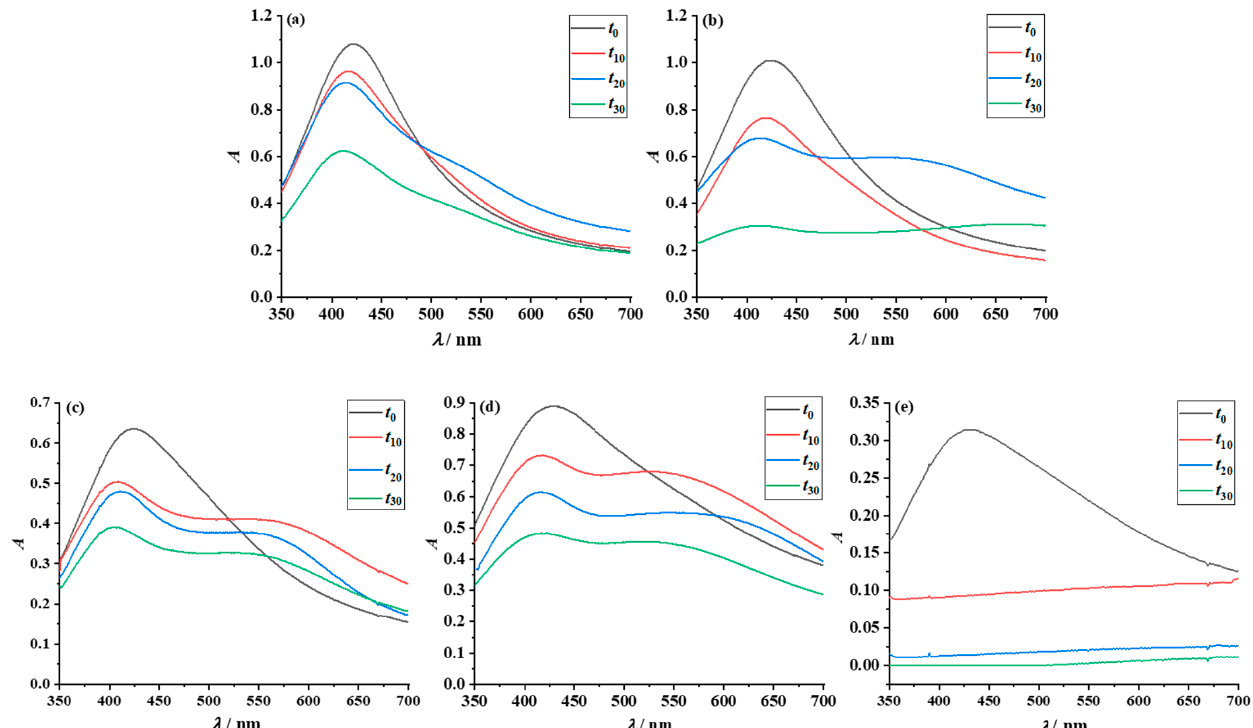
Figure 6. UV-Vis spectra recorded for PAA-AgNPs dispersed in: ( a ) water; ( b ) EG; ( c ) EtOH; ( d ) IPA; and ( e ) TpOH, over a 30-day period.